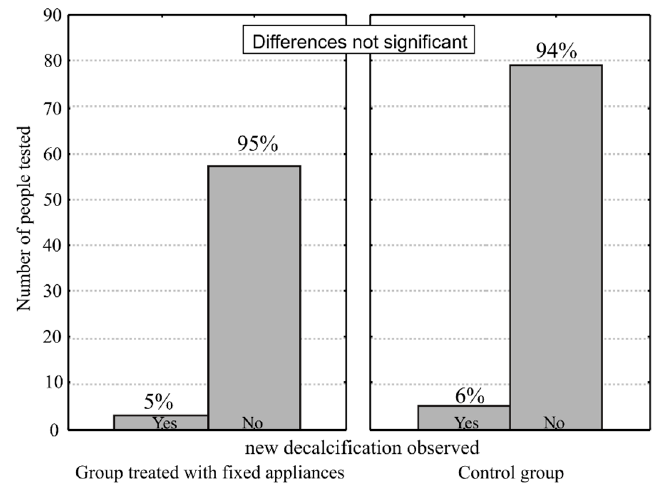
Figure 3. Graphical representation of people tested with new enamel decalcification.